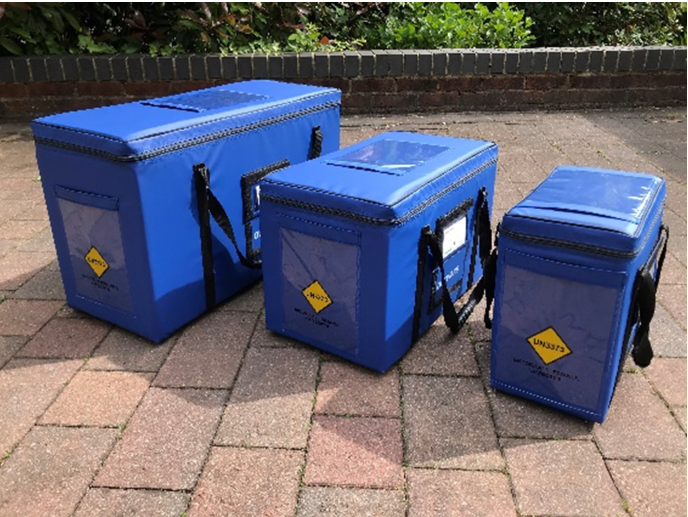
Figure 3. Typically used medical carriers, manufactured by the company “Versapak”. Centre (‘medium’) = 460 mm (w), 255 mm (D), 305 mm